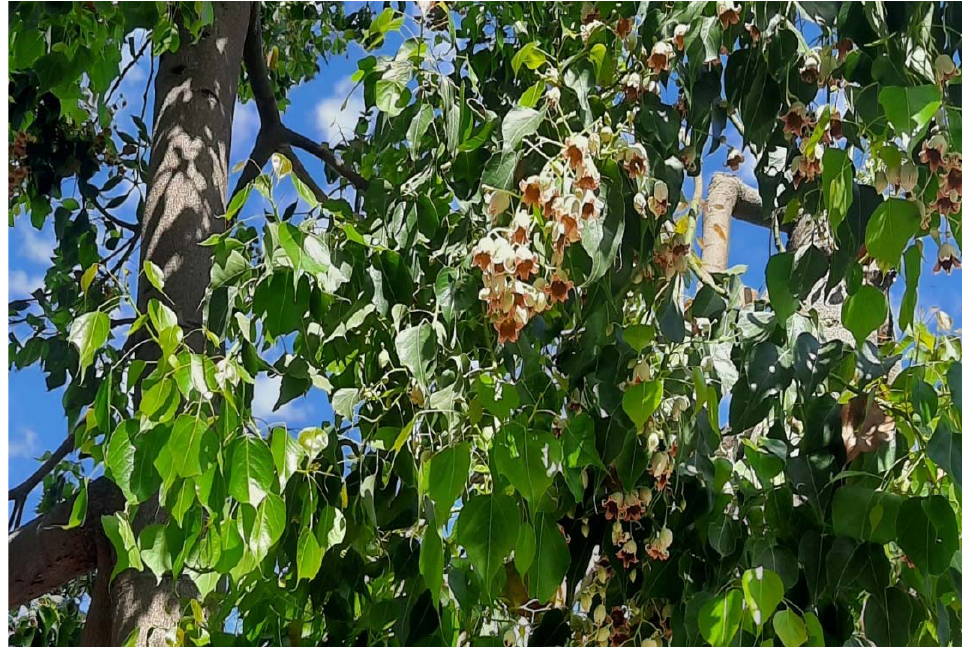
Figure 7. Sterculia diversifolia trees located in Amman, Jordan.